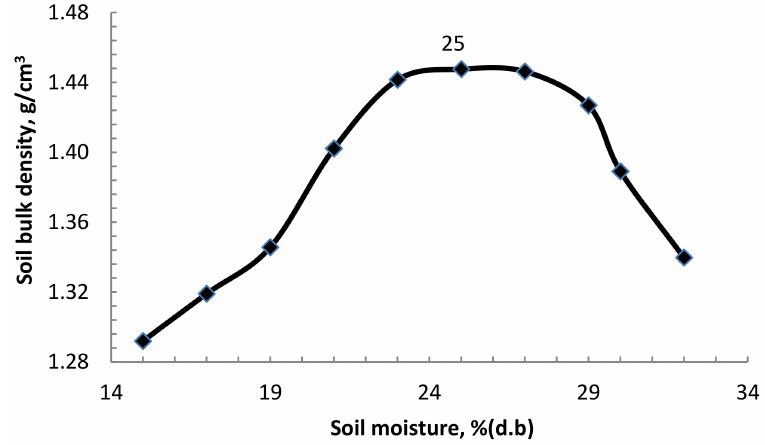
Figure 1. Determining the critical soil moisture using the proctor test.